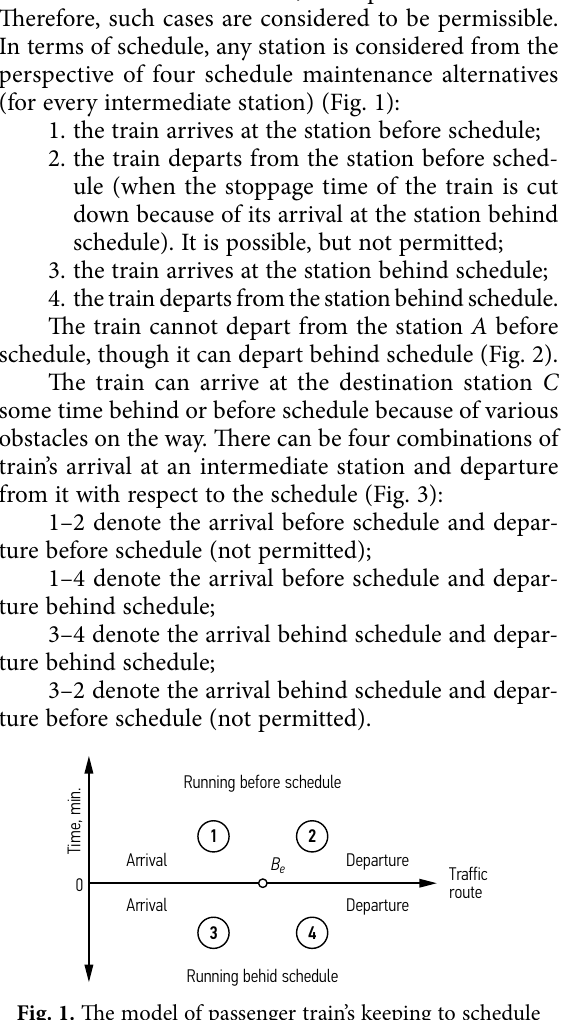
Fig. 1. The model of passenger train’s keeping to schedule at the intermediate station B